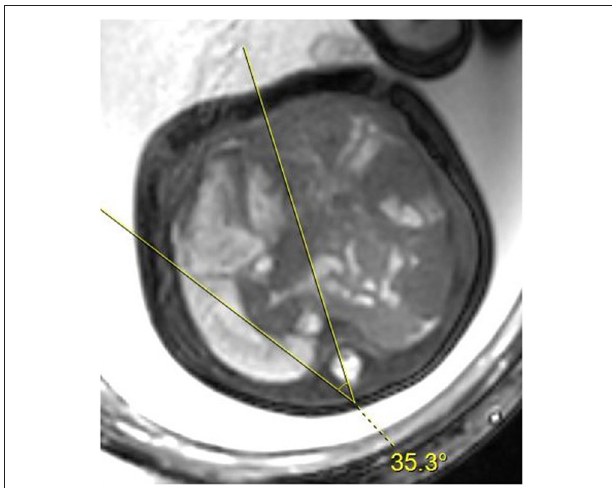
FIGURE 1 | Axial BTFE-BH image at the level of the four-chamber view of the fetal heart. The two lines delimit the angle of the mediastinal shift.